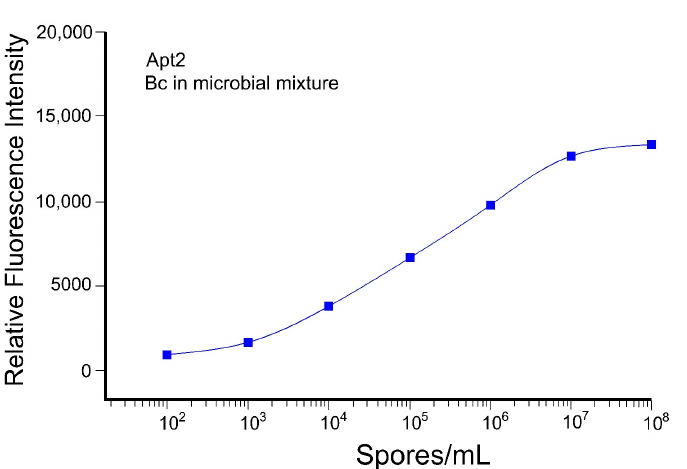
Figure 7. Range of detection using xMAP system . Detection of B. cereus (Bc) spores with Apt2 in the presence of 6 different biotechnology microorganisms as a microbial mixture. This experiment was performed in triplicate, and no significant difference was observed.